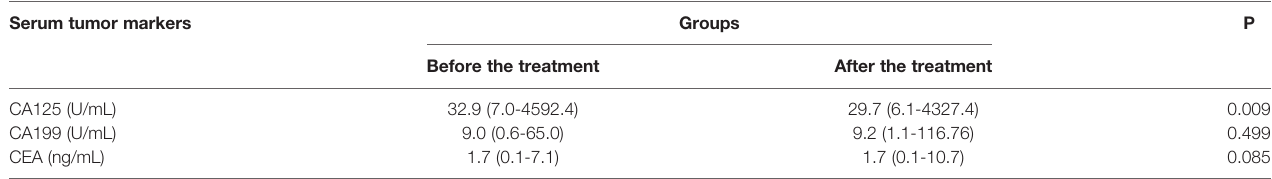
TABLE 3 | Evaluation of the serum tumor markers before and after apatinib treatment. Serum tumor